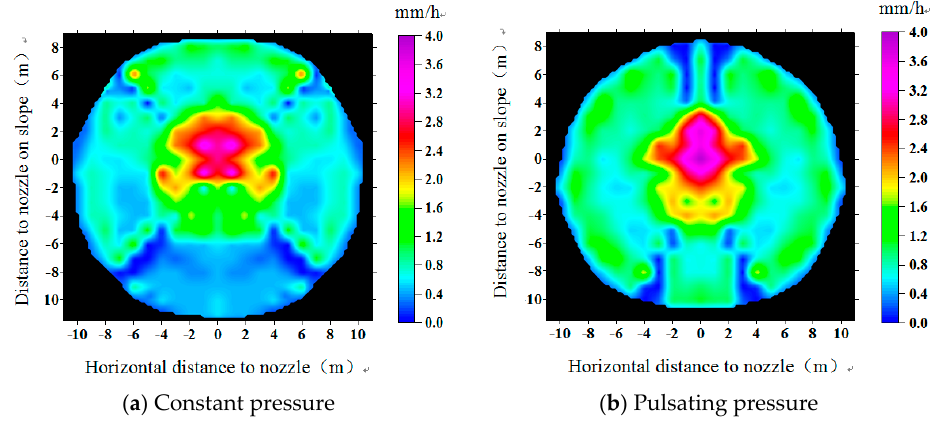
Figure 7. Water distribution for the single sprinkler.